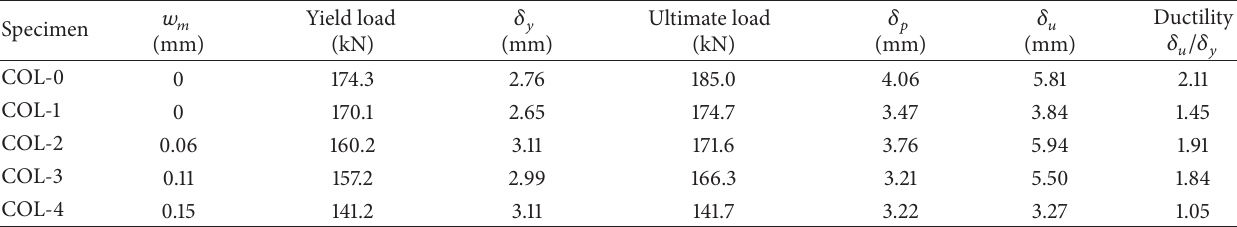
Table 3: Summary of static loading test results on column specimens.